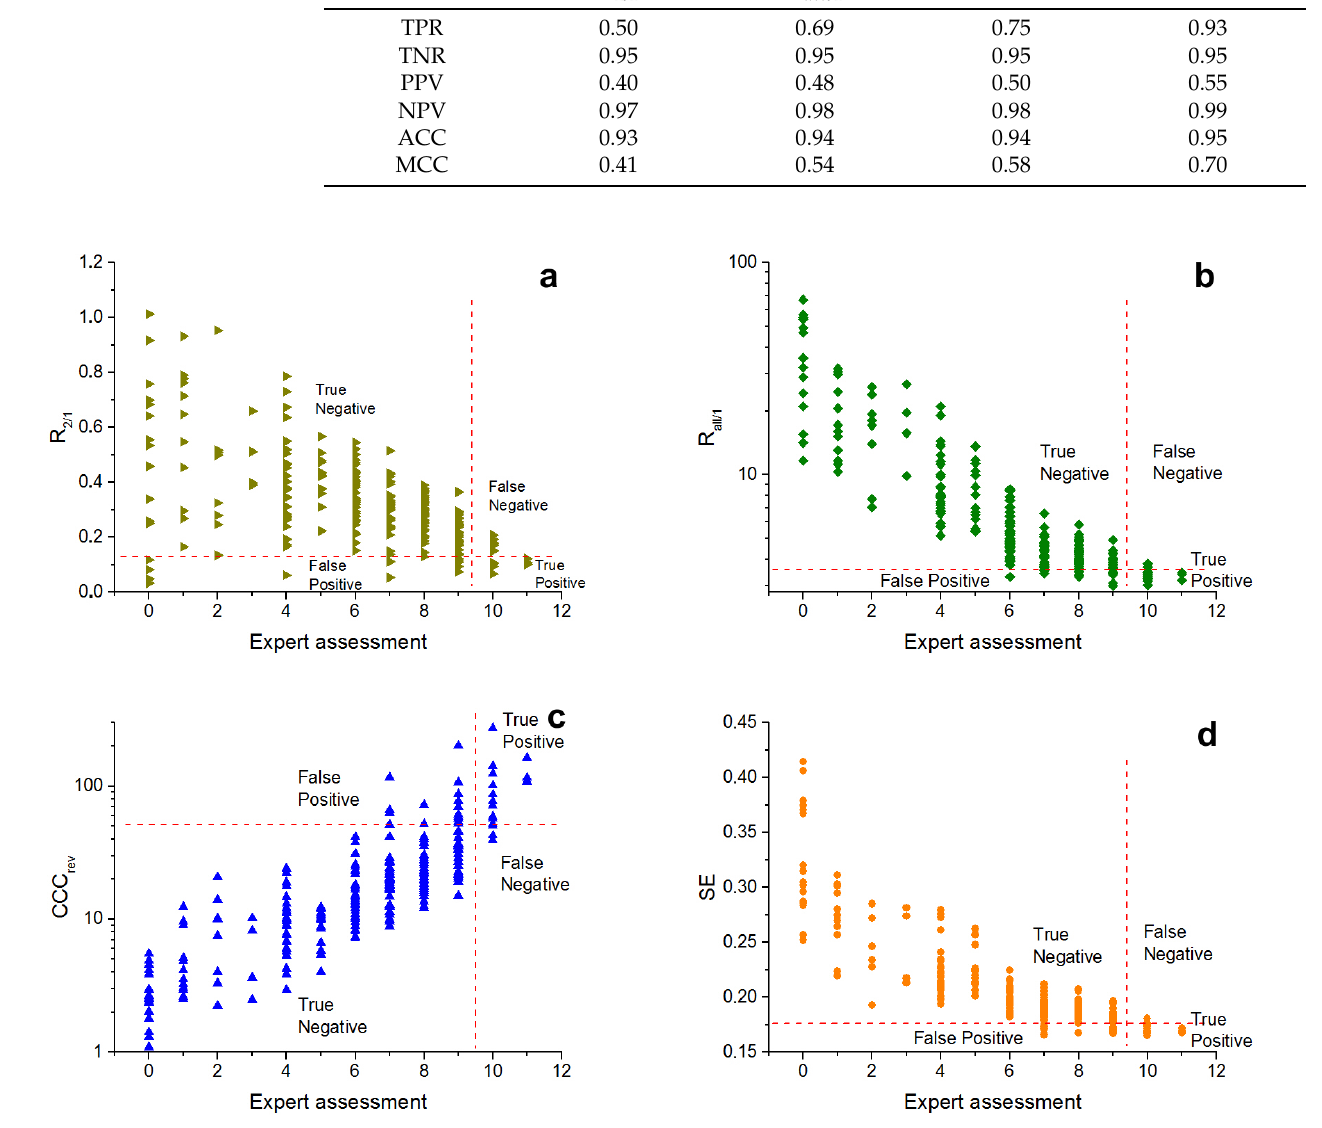
Figure 8. Distribution of the texture metrics in accordance to the expert assessments: R 2/1 ( a ), R all /1 ( b ), CCC rev ( c ), SE ( d ). Thresholds are given for hypothesis 1